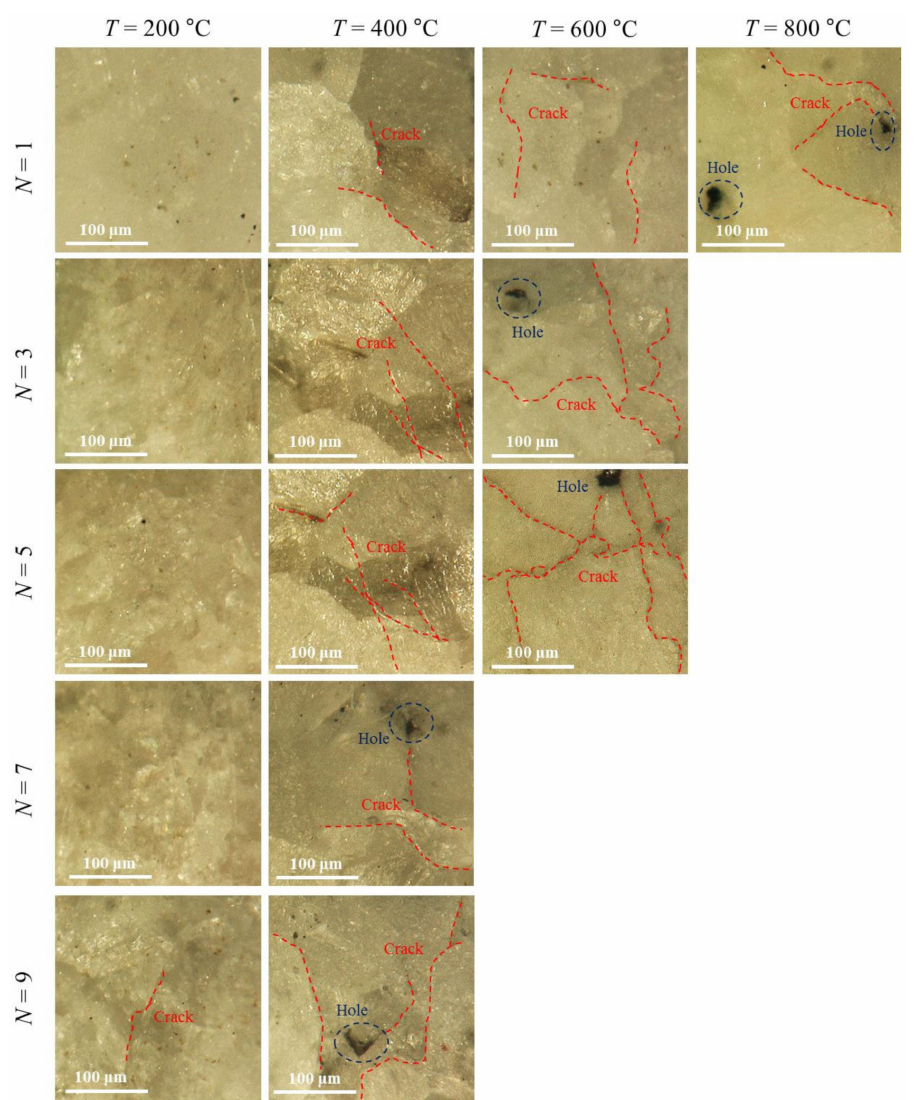
Figure 11. Microscopic thermal cracking feature of